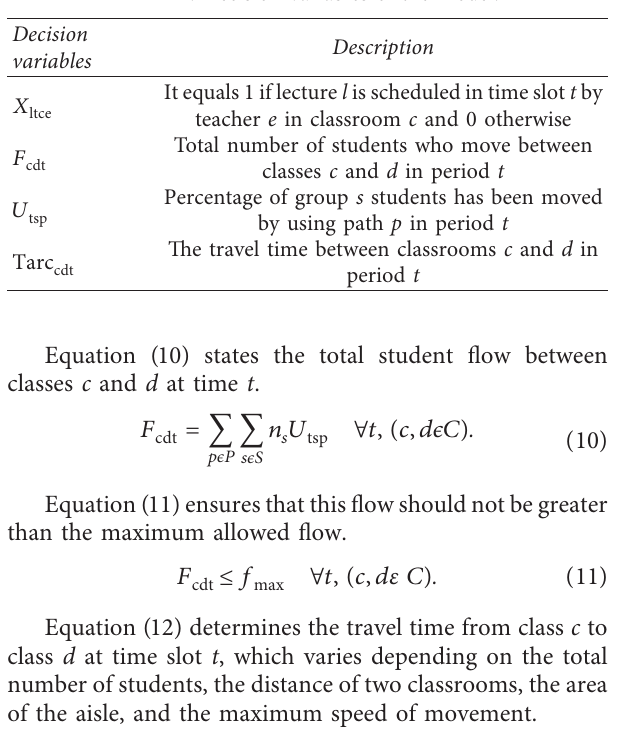
Table 4: Decision variables of the